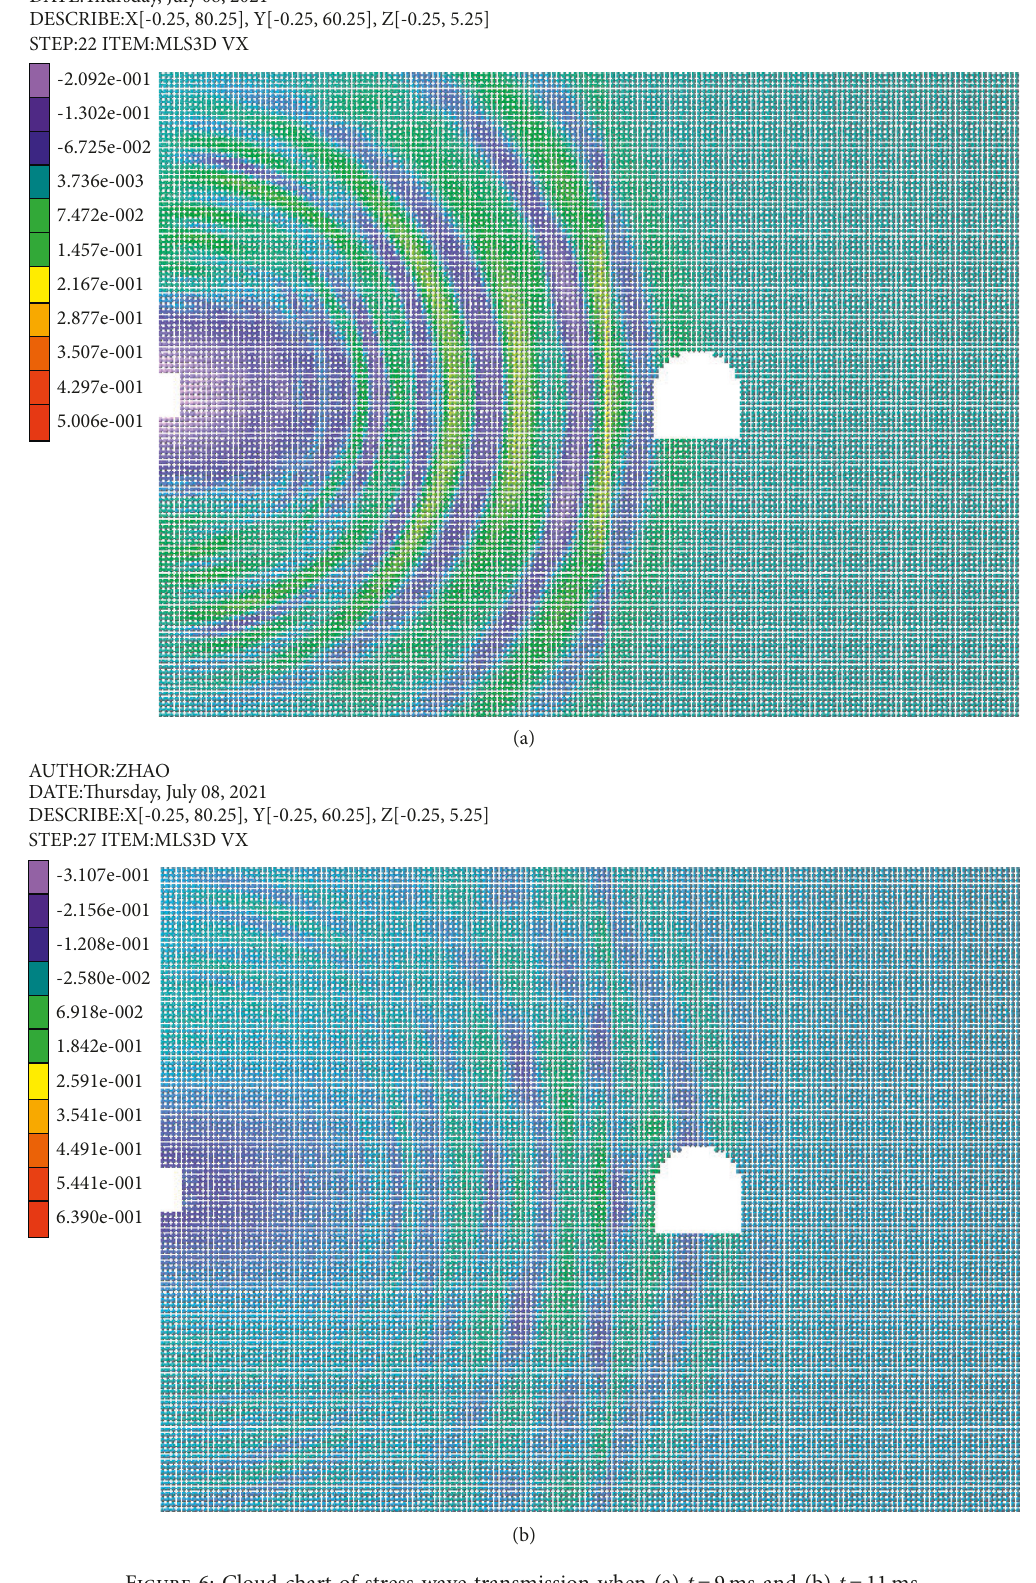
Figure 6: Cloud chart of stress wave transmission when (a) t � 9ms and (b) t �